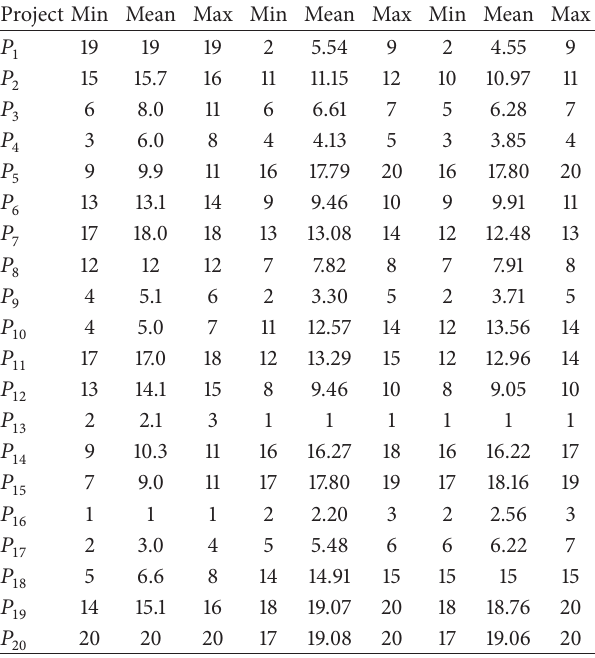
Table 2: The minimum, mean, and the maximum rankings with closeness coefficients created with (a) multidistance measure, (b) De Luca and Termini entropy measure, and (c) Parkash entropy measure.